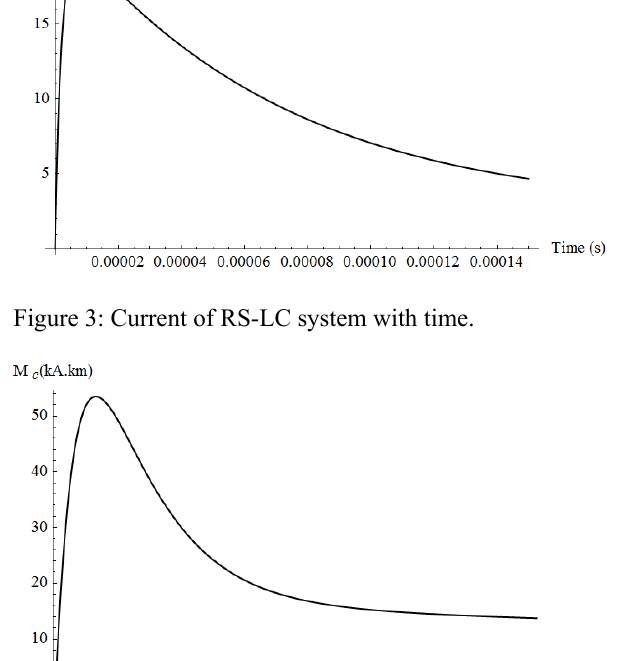
Figure 4: Current moment of RS-LC system with time.